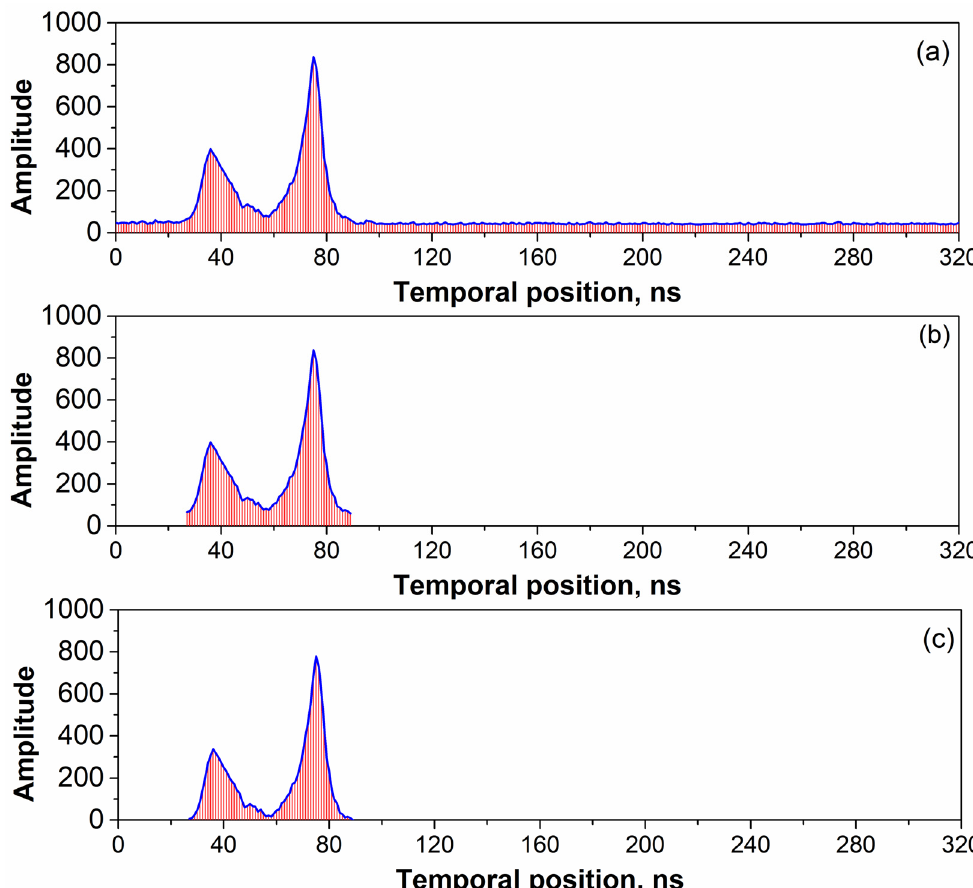
Figure 9. Extraction of the signal segment. ( a ) Raw echo waveform. ( b ) Adaptive extraction of the signal segment. ( c ) Signal segment after noise elimination.